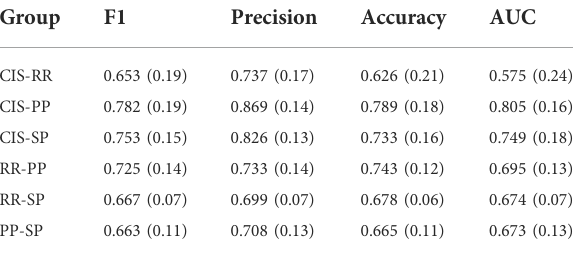
TABLE3Mean(st.dev)ofthepredictiveperformancesoftheensemble model across the ten foldsof the crossvalidationusing FSAverage